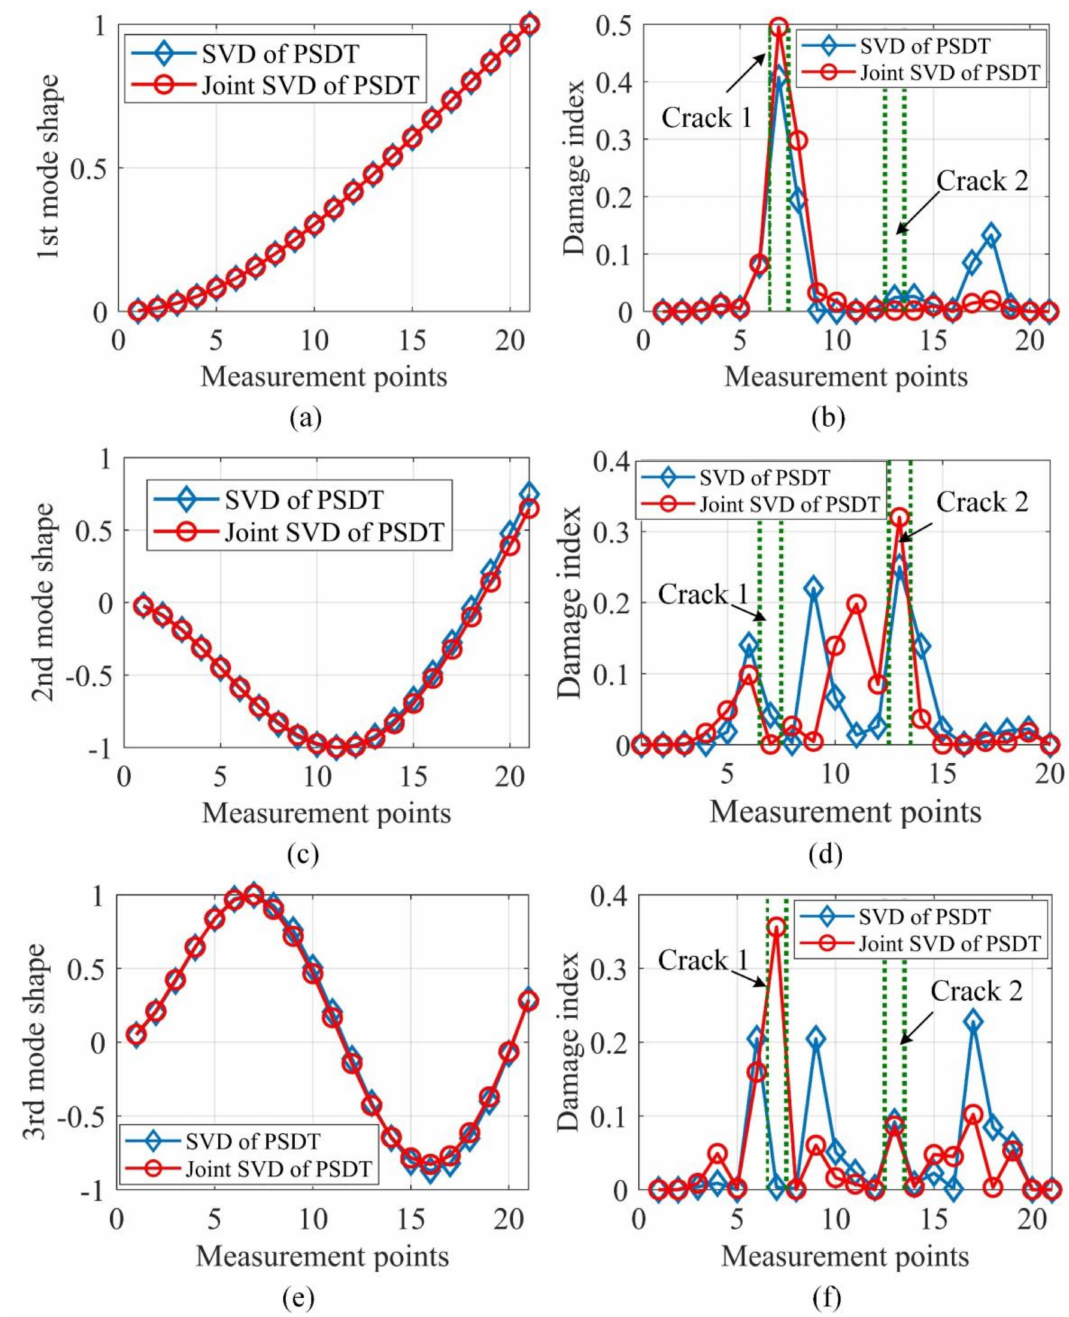
Figure 10. Estimated mode shapes and their individual damage localization results: ( a ) the 1st mode shape; ( b ) damage index of the 1st mode shape; ( c ) the 2nd mode shape; ( d ) damage index of the 2nd mode shape; ( e ) the 3rd mode shape; ( f ) damage index of the 3rd mode